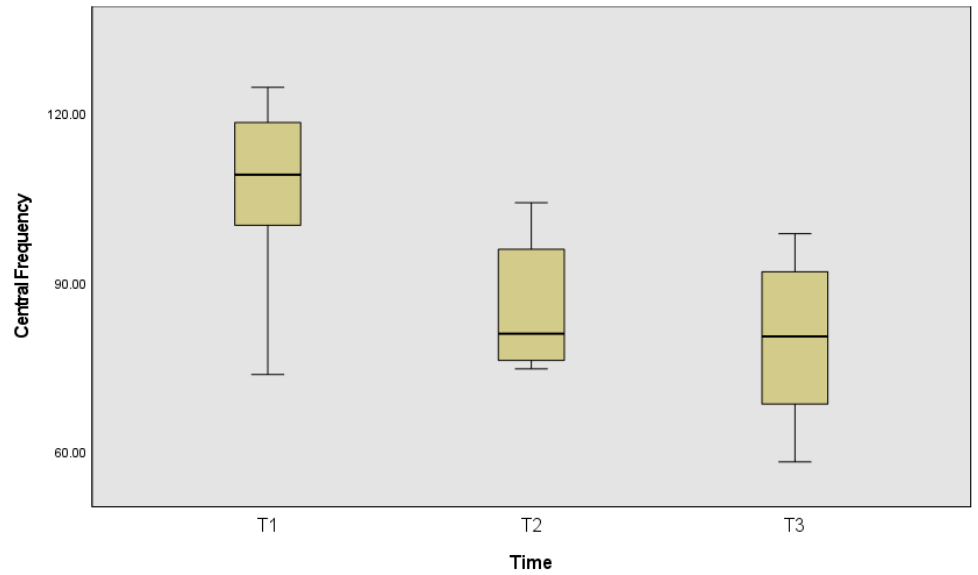
Figure 3. Central frequencies in Hz, at the beginning of acquisition (T1), in the middle (T2) and during the reported fatigue (T3).